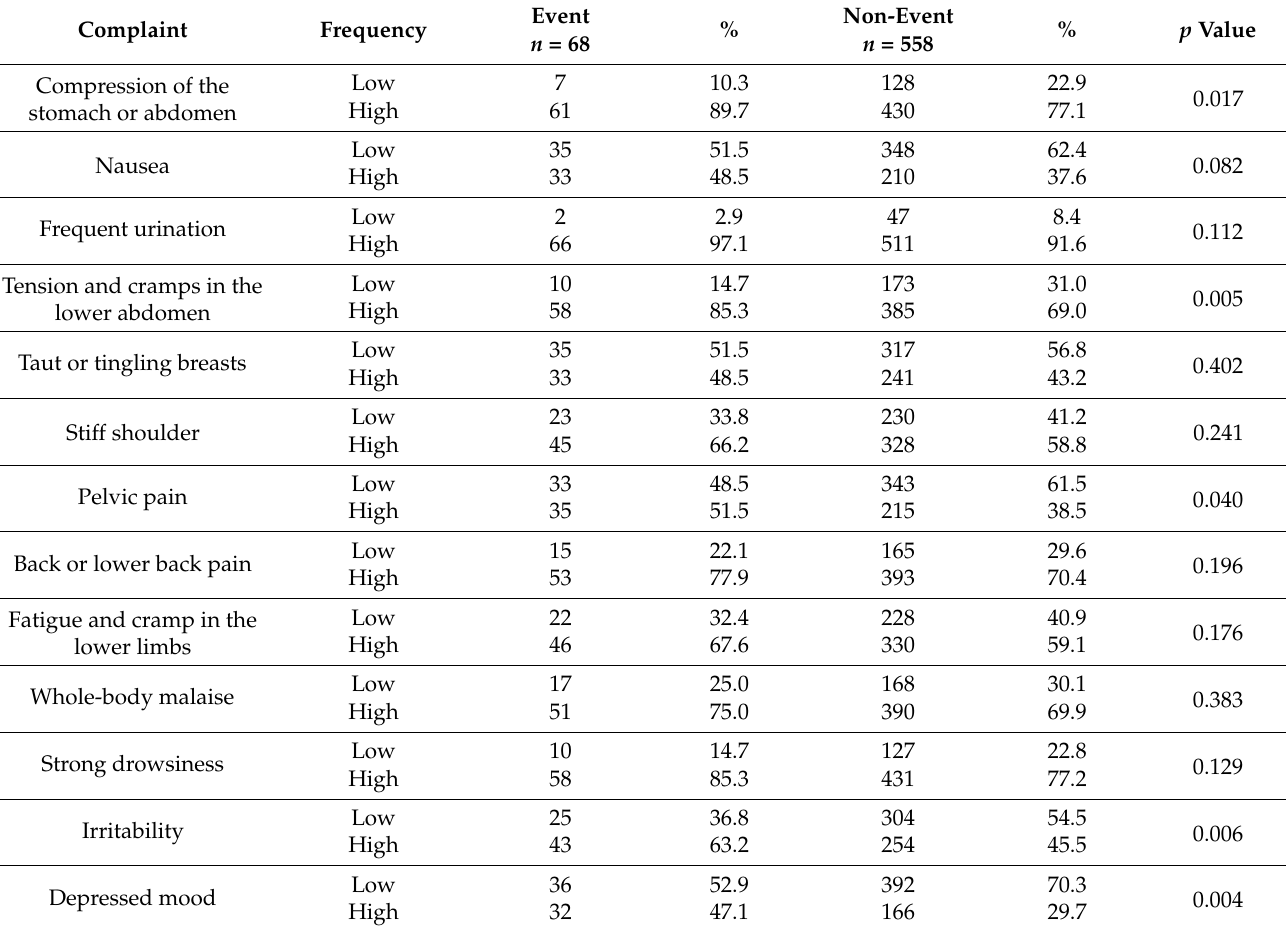
Table 2. Comparison of the frequency of each common complaint in pregnancy between event and non-event